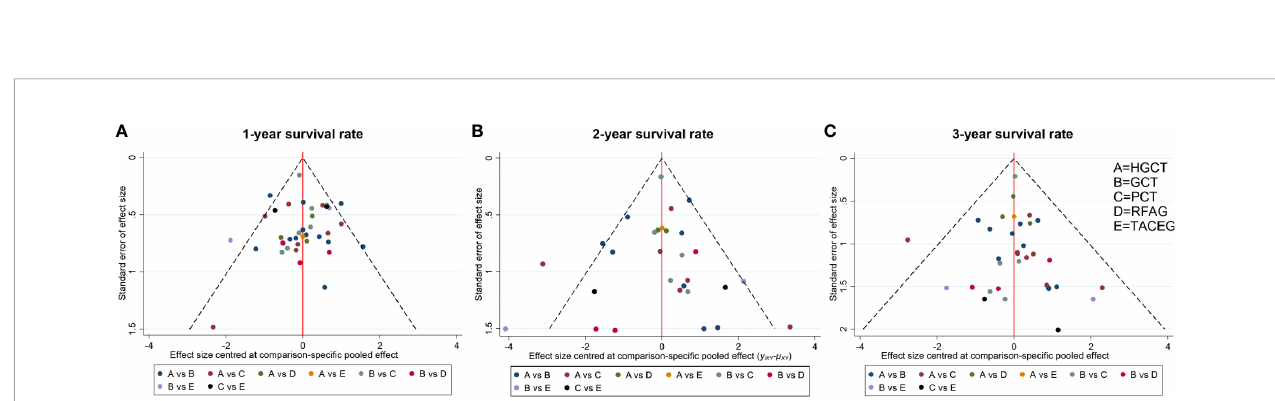
FIGURE 7 | Comparison-adjusted funnel plot for the network meta-analysis. The red line suggests the null hypothesis that the study-speci fi c effect sizes do not differ from the respective comparison-speci fi c pooled effect estimates. Different colors represent different comparisons. (A) 1- year survival rate. (B) 2- year survival rate. (C) 3- year survival